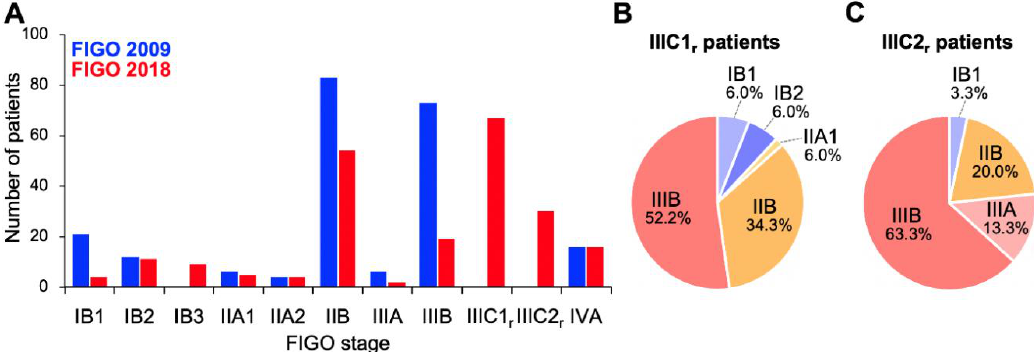
Figure 1. Stage distribution of patients with squamous cell carcinoma of the cervix based on the International Federation of Gynecology and Obstetrics (FIGO) 2009 or 2018 staging criteria. ( A ) Entire cohort ( n = 221). ( B ) FIGO 2018 stage IIIC1 r patients stratified by FIGO 2009 staging criteria ( n = 67). ( C ) FIGO 2018 stage IIIC2 r patients stratified by FIGO 2009 staging criteria ( n = 30).